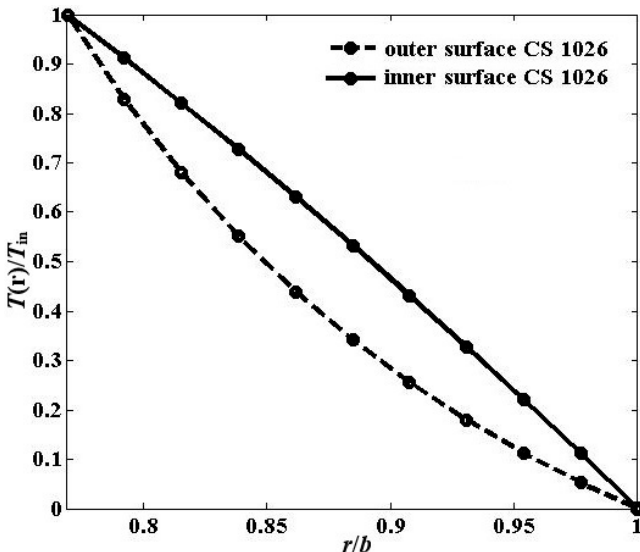
Figure 9. Temperature profiles through-thickness of the FGM pipe with b / a = 1.3 for two prescribed FGM profiles including the inner and outer surfaces made of CS 1026.